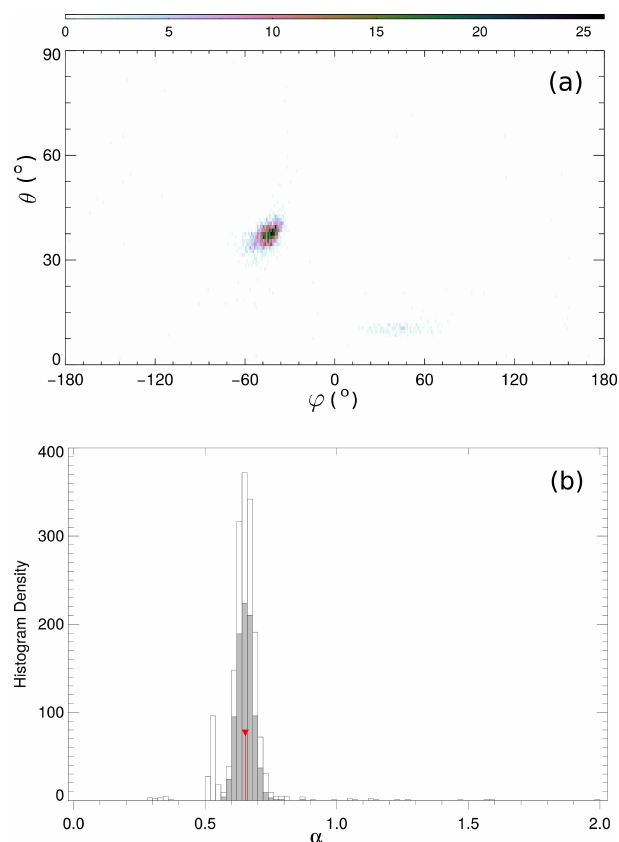
Figure 3. The cleaning parameters resulting from the sliding win- dow scan for the first-order correction of the outboard FGM. The top panel shows the number density of the maximum-variance di- rection (θ w ,ϕ w ) on a 1 ◦ × 1 ◦ grid. The bottom panel shows a his- togram of the statistical distribution of the α w coefficients. The grey filled bars are the coefficients corresponding to directions within 2 . 5 ◦ from most probable direction. The red vertical line marks their mean